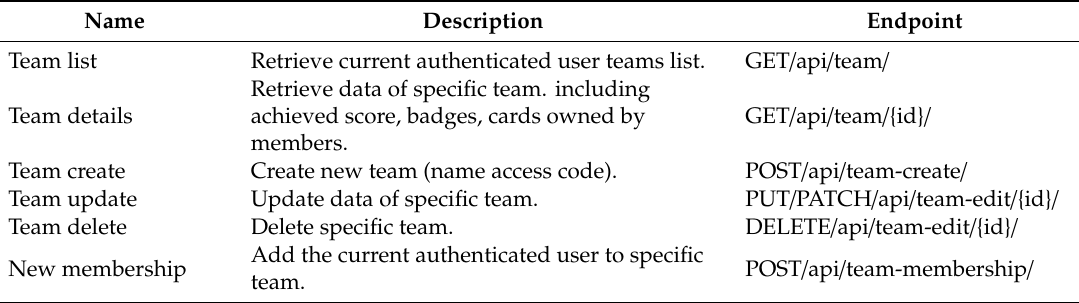
Table 5. Team management endpoints.